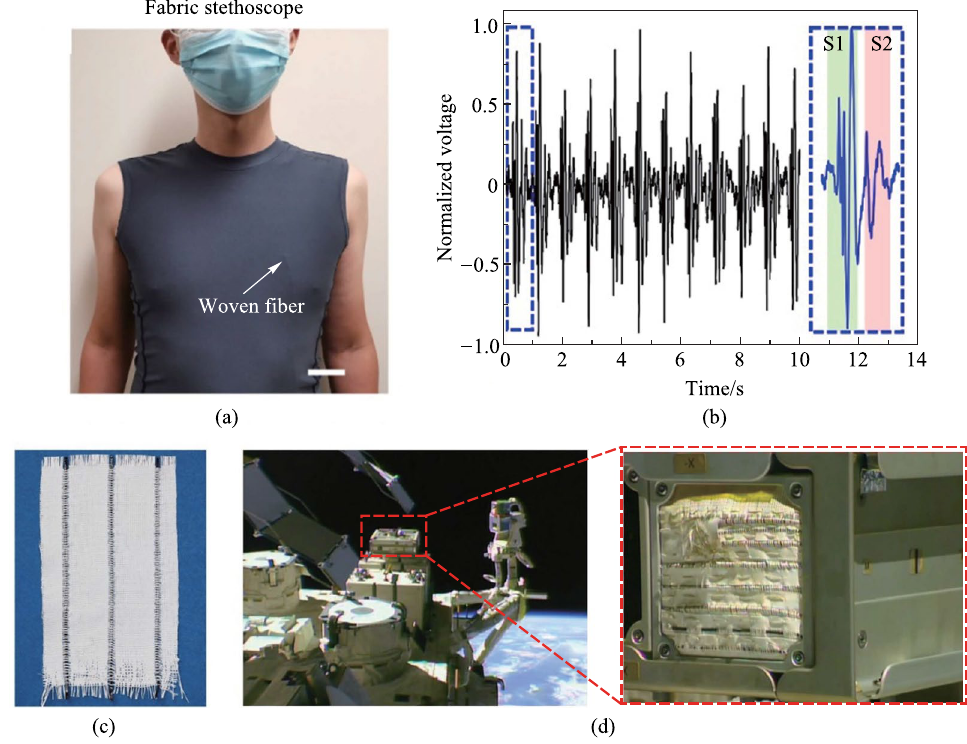
Fig. 8 TDPF fabrics for health care and space dust sensing. a Photograph of the experimental scenario of the fabric stethoscope. b Detected car- diac signals from the fabric stethoscope. c A fabric containing three black TDPF sensors for dust sensing. d Photograph showing sensing fabrics mounted on the Exposed Experiment Handrail Attachment Mechanism (ExHAM) facility on the International Space Station (ISS). The experi- ment, which began in October 2020, has been studying the resiliency of different types of fabric sensors when they are exposed to the harsh environment of low Earth orbit. The amplified image shows details of the mounted fabric. Reprinted with permission from Refs. [75,